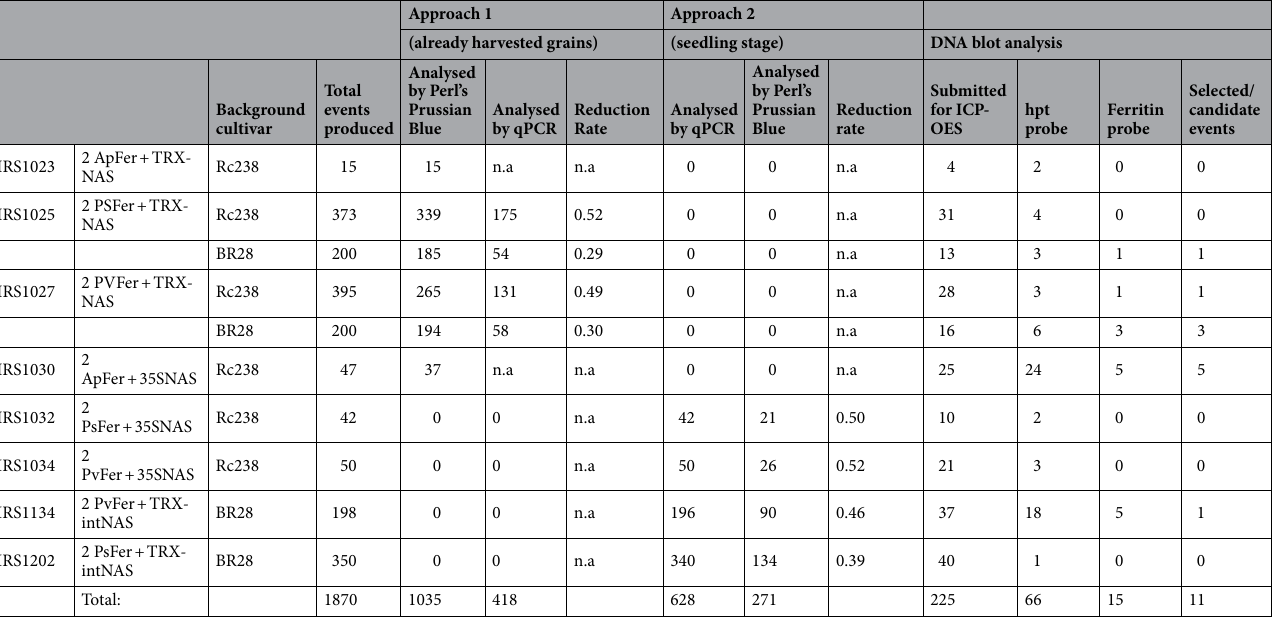
Table 1. Summary of constructs developed for transformation in cultivars Rc238 and BR28 for the purposes of the HIZR project at IRRI, as well as the actual number of the events analyzed per construct per cultivar. In total 1870 events were produced, and 1663 events were analyzed by Perl’s Prussian Blue staining and qPCR for copy number variation. Subsequently, 225 events were selected and submitted for inductively coupled plasma optical emission spectrometry to detect the Fe and Zn concentration in polished grains. The copy number of 66 samples exhibiting high Fe and Zn content was determined by DNA blot analysis using initially the hygromycin (hpt) probe and later the ferritin (transgene-of-interest) probe. Eventually, 11 events were selected for further analysis under field